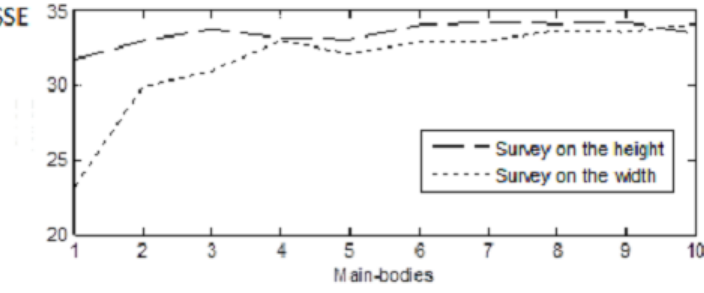
Figure 12. Sum of square errors for various widths and heights of the detected windows. The best choice is five.